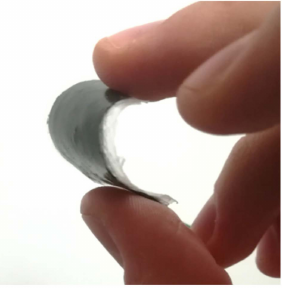
Figure 16. Image of the flexible piezoelectric